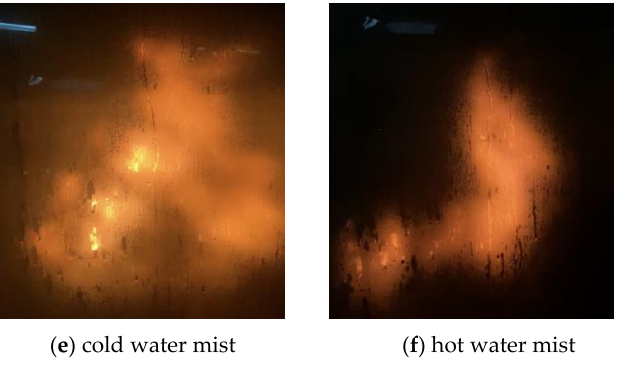
Flame diagram under the action of hot and cold water mist for 3 s